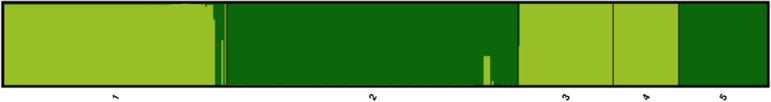
Population structure for grouping based on haplotype network constructed by using the statistical parsimony method for 16S gene of Chrysoperla externa.Each individual is represented by a thin vertical line, which is partitioned into coloured segments that represent the individual’s probability of belonging to the cluster with that colour. Colors represent clusters (K), interpreted as mutational steps from an ancestral haplotype not present in the analysis.